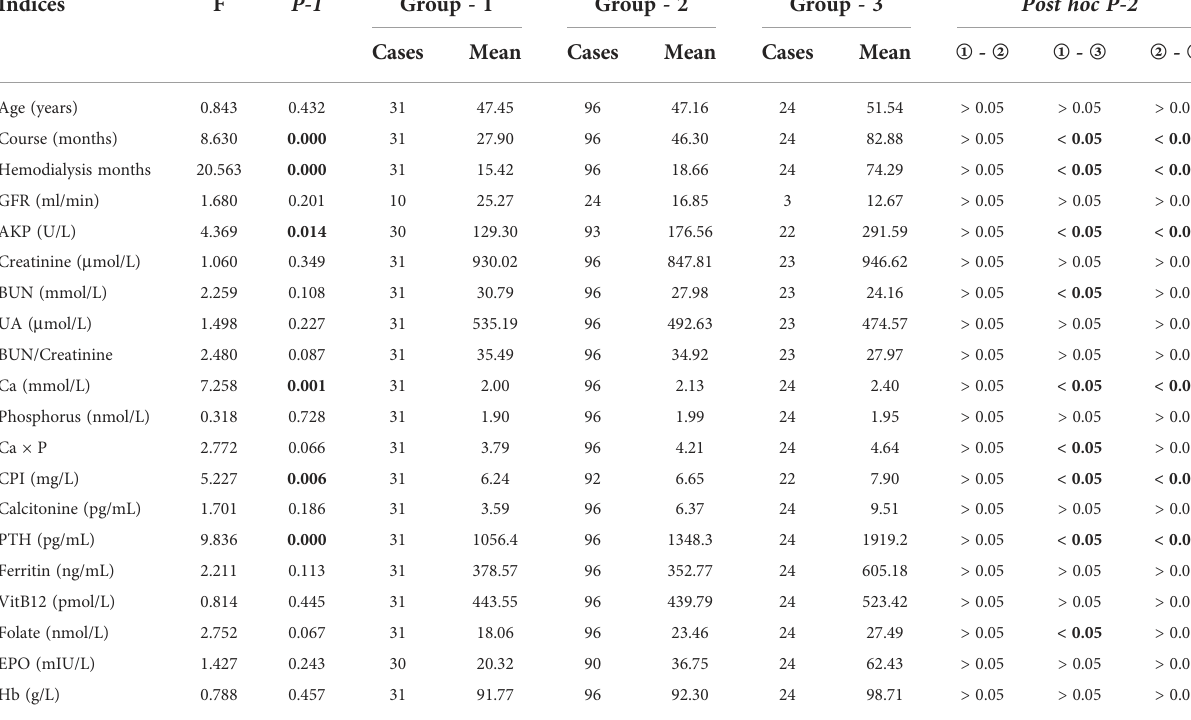
TABLE 3 The comparison of some indices among three qualitative groups during early phase.